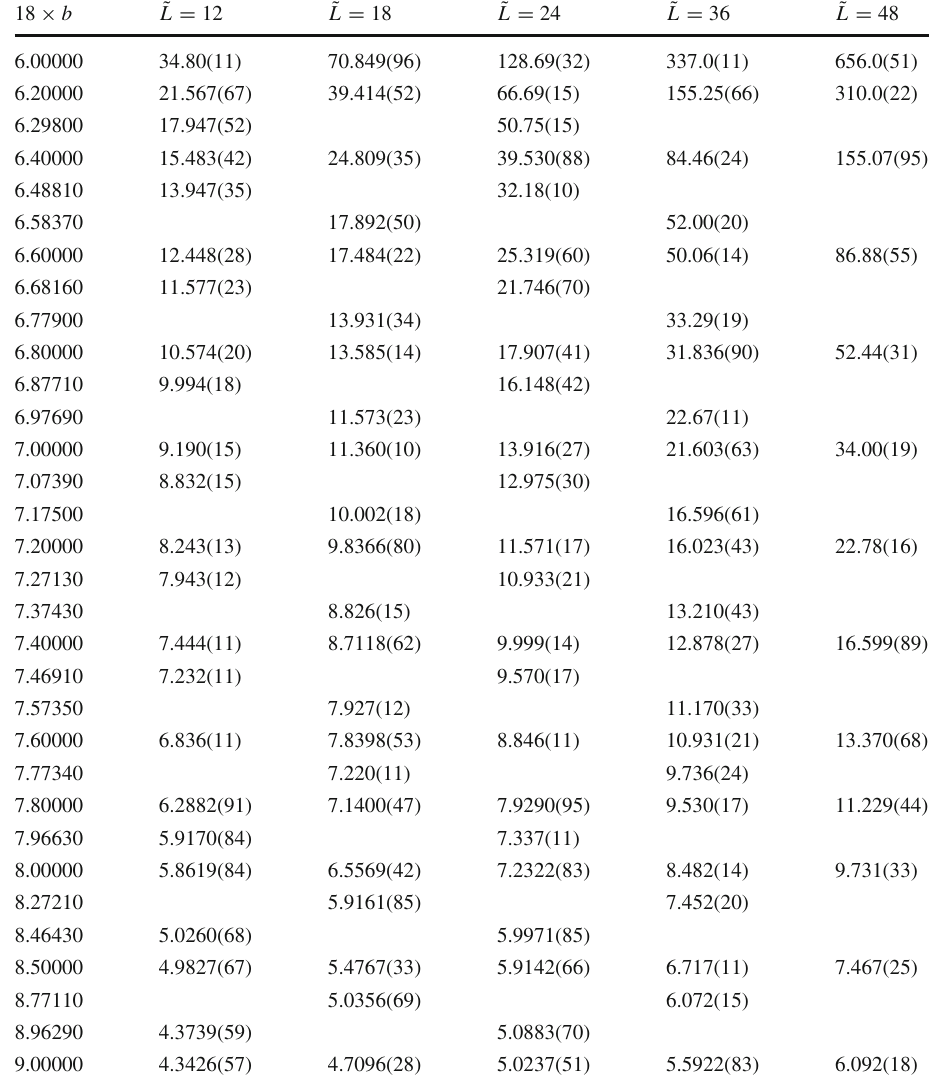
Table 7 TGF ’t Hooft coupling data as a function of the inverse bare coupling b = 1 /λ 0 and the lattice size ˜ L = ˜ l /